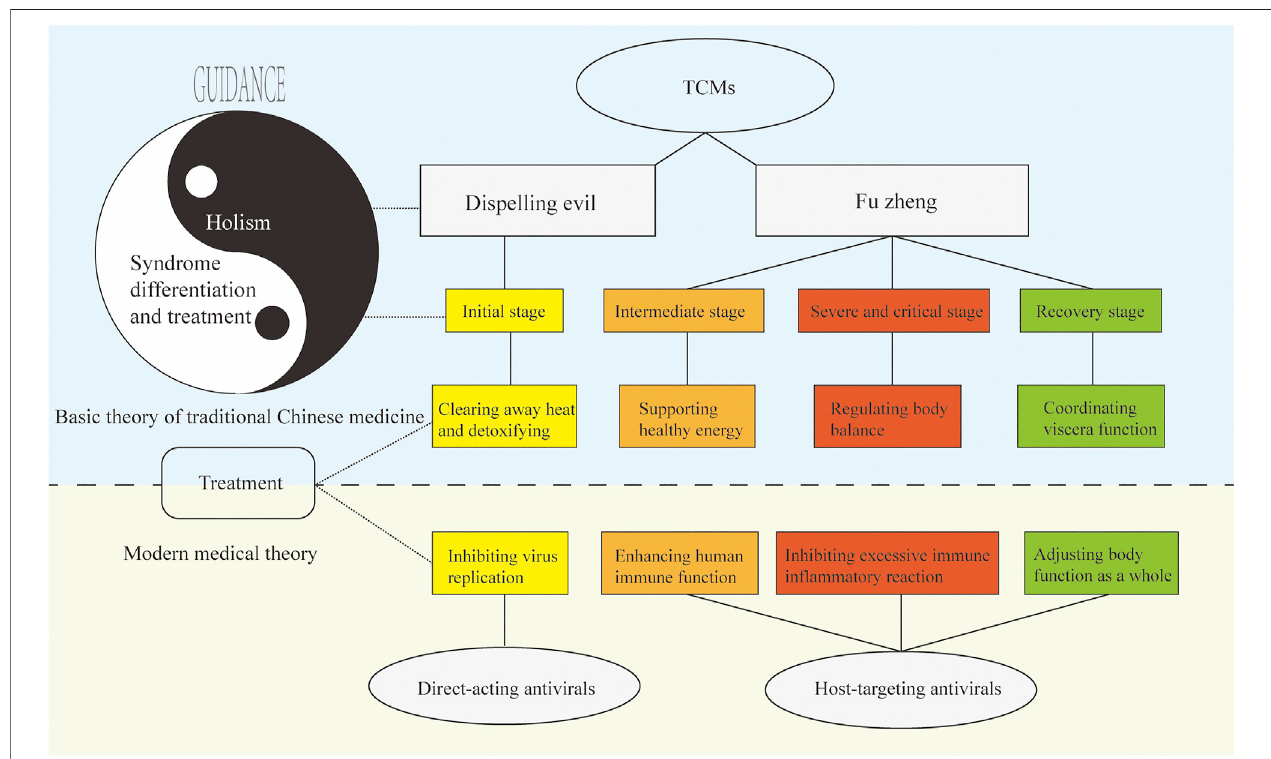
FIGURE 1 | TCM antiviral theory based on the basic theory of TCM and its relationship with modern medicine. Under the guidance of “ holism ” and “ syndrome differentiation and treatment ” , TCM can remove pathogenic factors and strengthen the body, to achieve the effect of preventing and treating viral diseases, which is corresponding to the modern medical